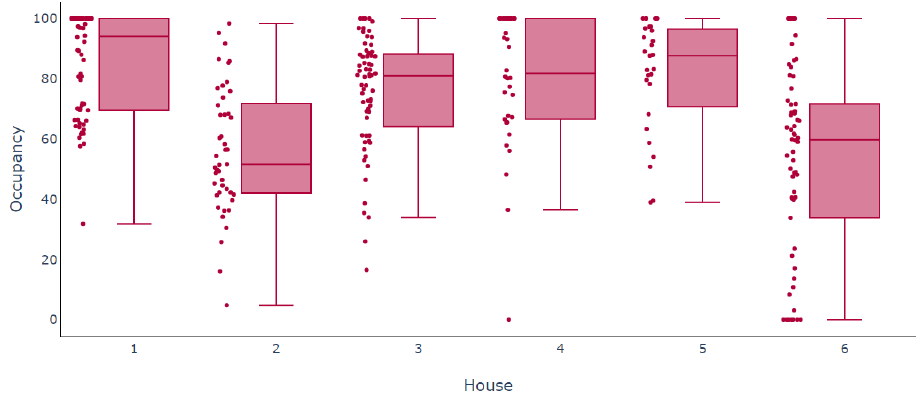
Figure 4. Daily occupancy rate for each measured day by house [%].